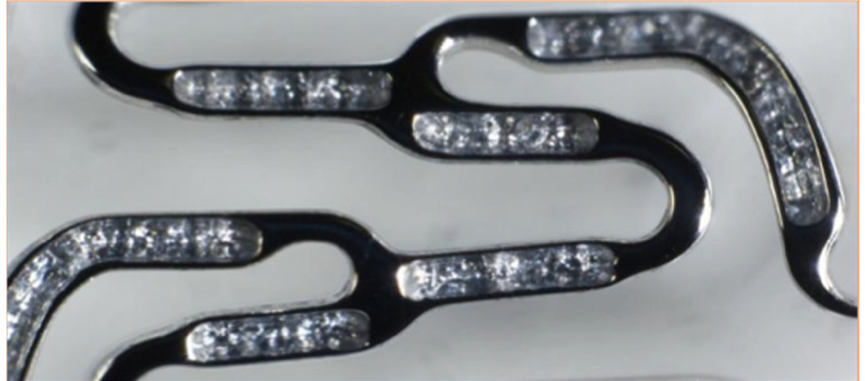
Figure 3. The abluminal reservoirs of Cre8 eluting stent [32].